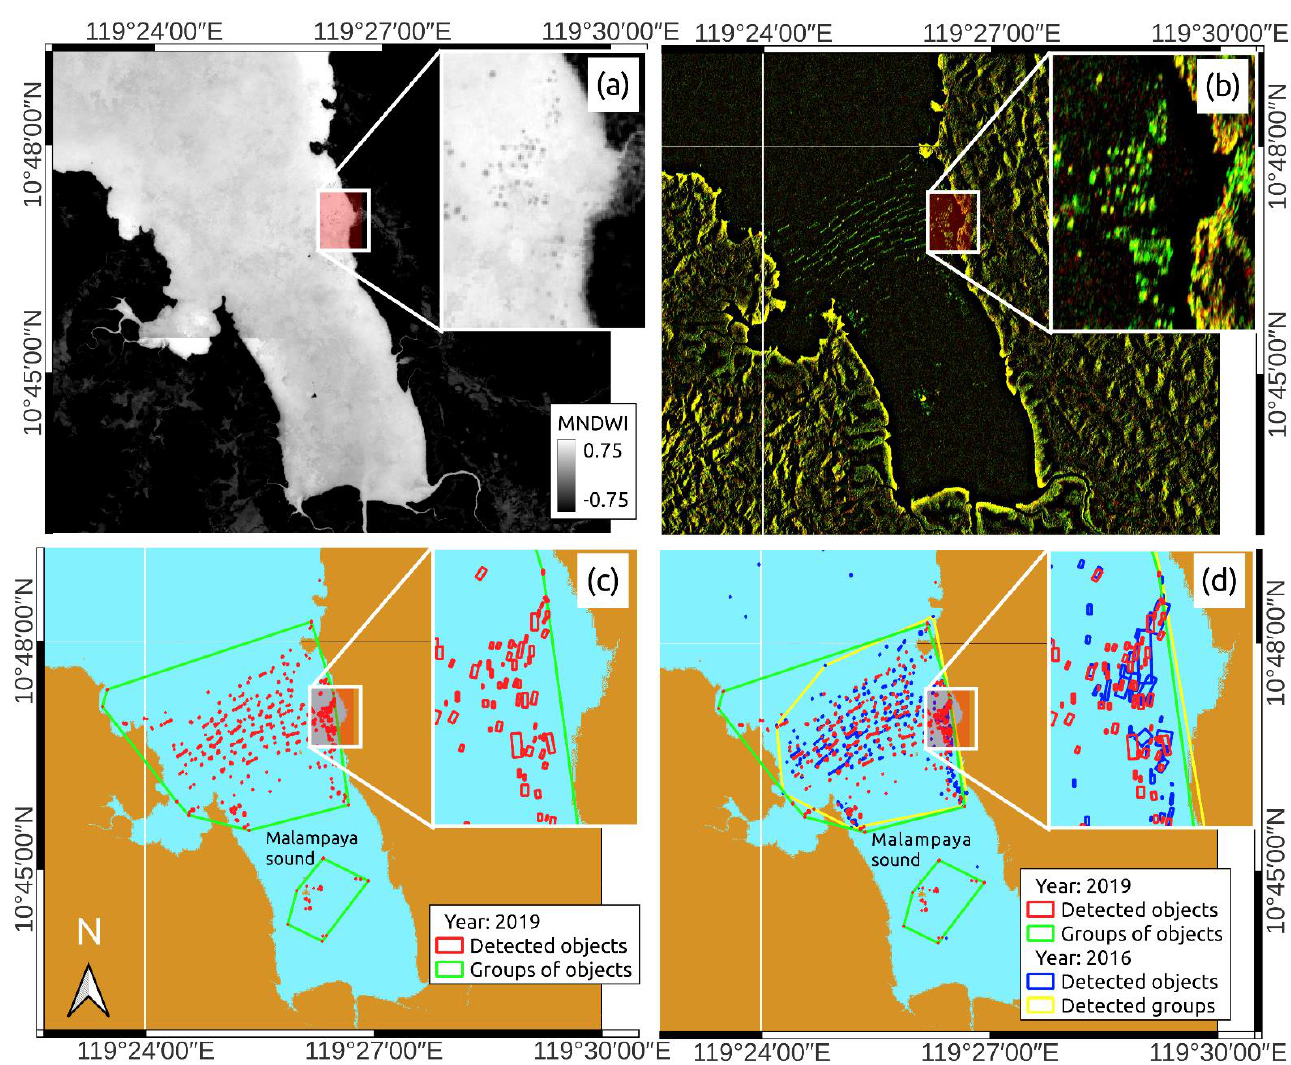
Figure 7. Generated maps of aquaculture structures in Malampaya Sound, Palawan, Philippines: ( a ) a modified NDWI index map generated from Sentinel-2 MSI data; ( b ) Sentinel-1 SAR image composite RGB image with VV polarisation shown in red and VH polarisation in green; ( c ) a map of aquaculture structures in the year 2019; ( d ) a combined map of aquaculture structures in the years 2016 and 2019.